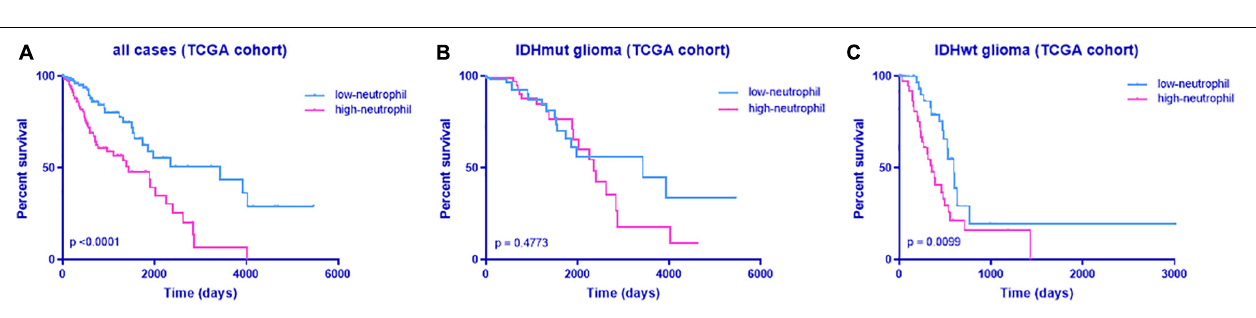
FIGURE 4 | Analyses of neutrophil chemokine expression in IDHwt glioma according to TERT mutation. (A) All samples from TCGA cohort. (B) IDHwt samples from TCGA cohort. ** p < 0.01; *** p < 0.001; **** p < 0.0001; NS, not significant.